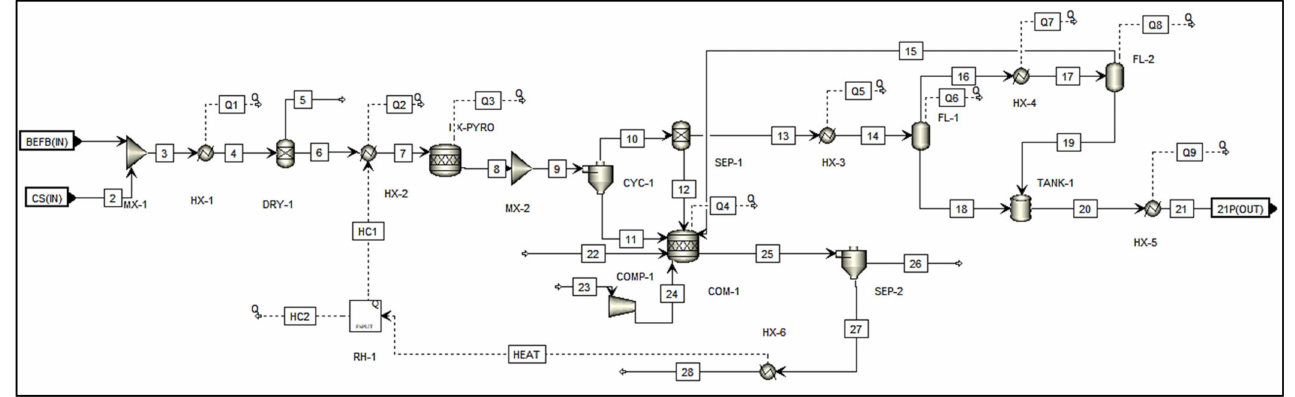
Figure 3. Process flowsheet diagram of the pyrolysis